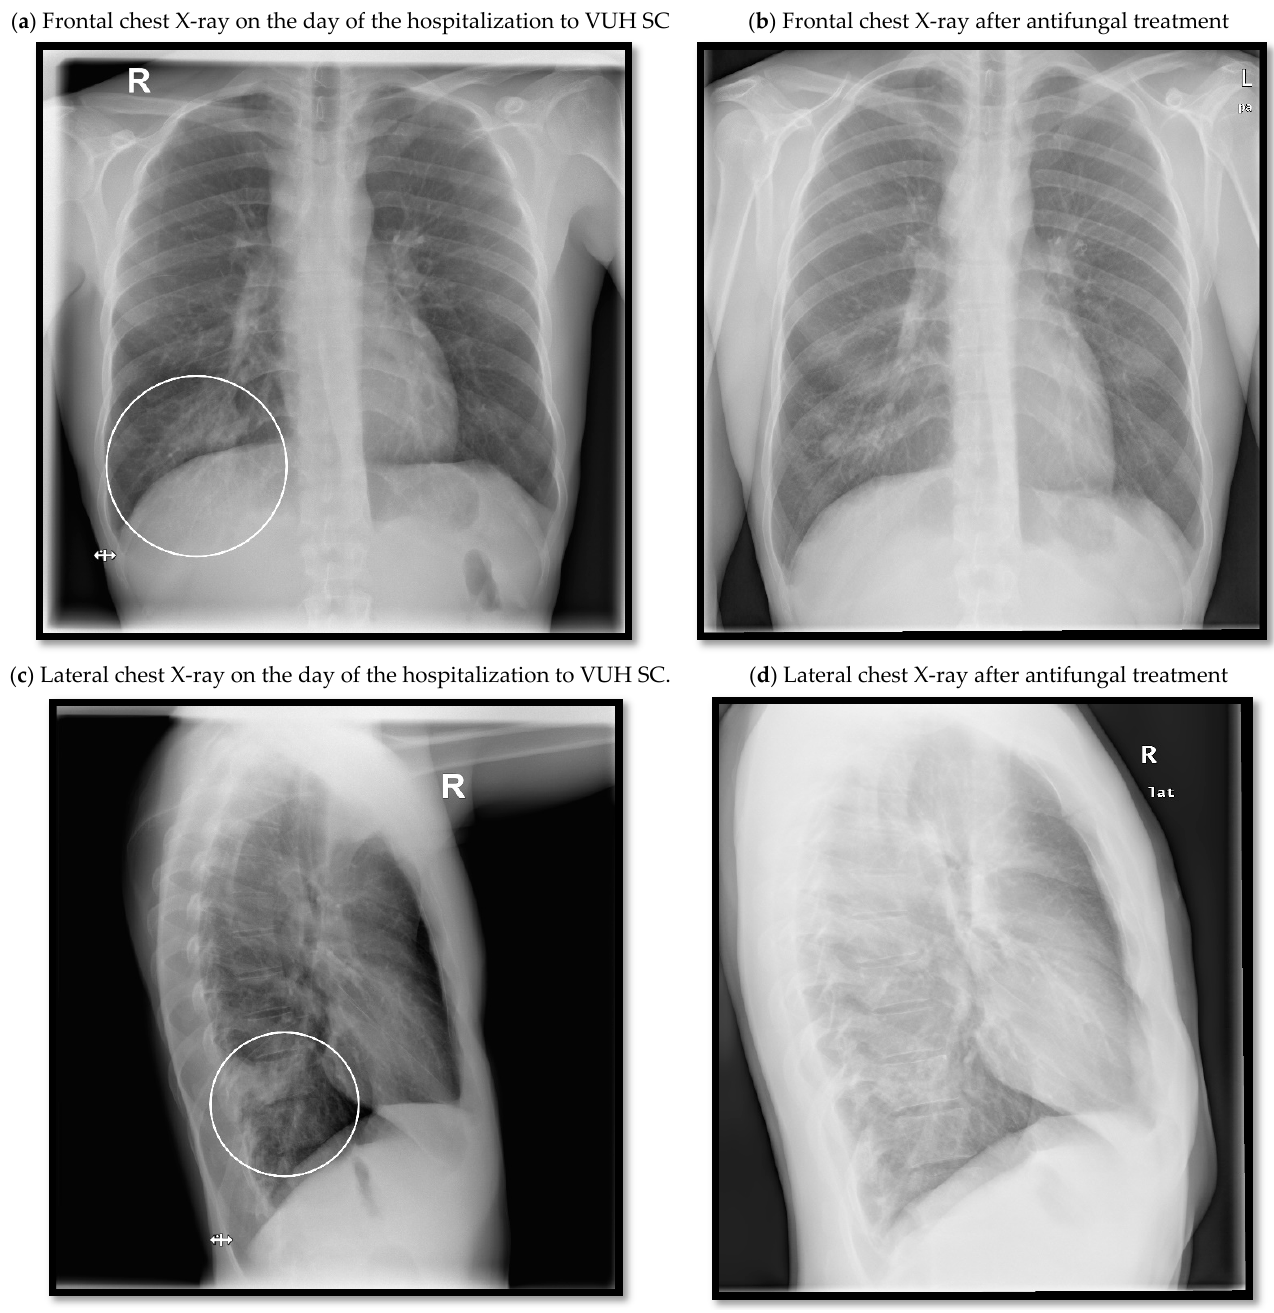
Figure 2. Frontal and lateral chest X-rays showing dynamics of the infiltration in the basal segment of the right lung.